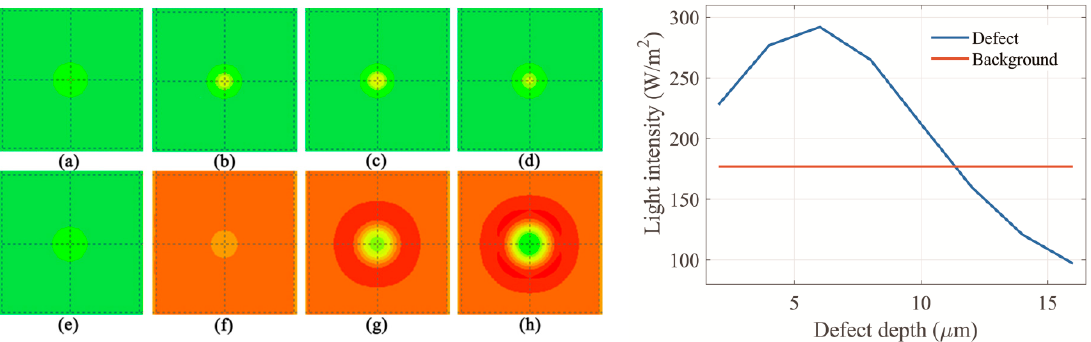
Figure 2. TracePro simulation example of different defect depths resulting in different irradiances. ( a ) 2 μ m, ( b ) 4 μ m, ( c ) 6 μ m, ( d ) 8 μ m, ( e ) 10 μ m, ( f ) 12 μ m, ( g ) 14 μ m, and ( h ) 16 μ m. ( i ) Light intensity versus defect depth.